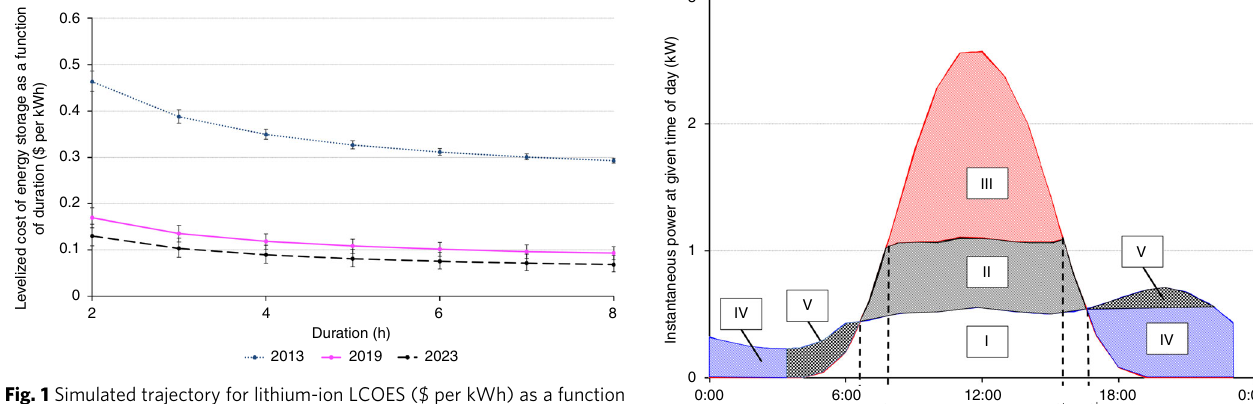
Fig. 1 Simulated trajectory for lithium-ion LCOES ($ per kWh) as a function of duration (hours) for the years 2013, 2019, and 2023. For energy storage systems based on stationary lithium-ion batteries, the 2019 estimate for the levelized cost of the power component, LCOPC, is $0.206 per kW, while the levelized cost of the energy component, LCOEC, is $0.067 per kWh. The curve corresponding to the year 2019 plots the corresponding LCOES values for alternative levels of the storage system ’ s duration.